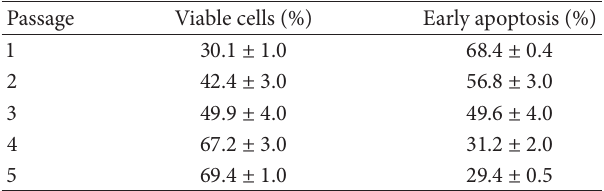
Table 4: Percentage of viability and early apoptosis at various passages of